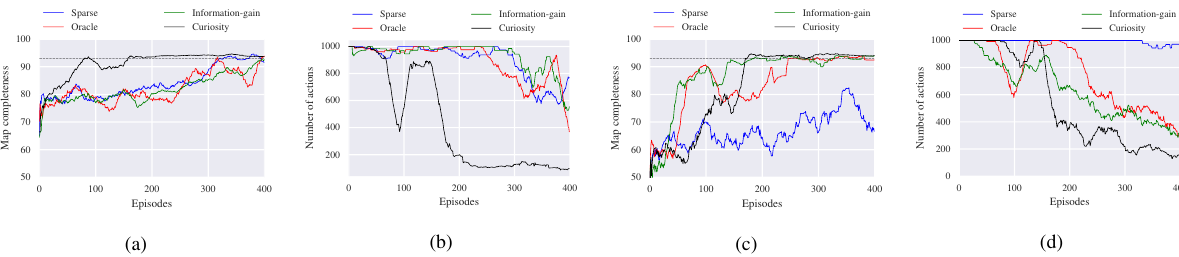
Figure 4. The training results in Env-1 when the robot starts each training episode in the same position, Figure 4a and 4b, and when its pose is randomly selected, Figure 4c and 4d. The Sparse corresponds to the sparse reward function, the Oracle to the map-completeness reward function, the Information-gain to the entropy based reward function and Curiosity to the proposed reward